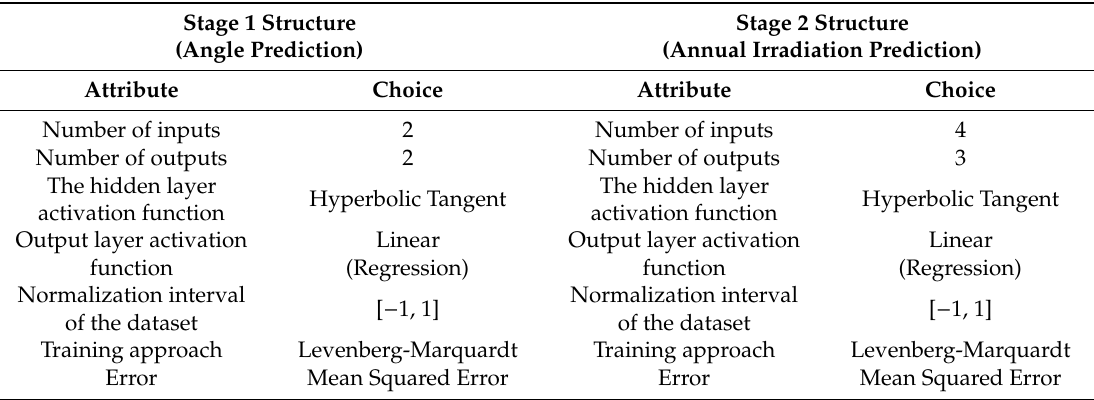
Table 2. The parameters of the proposed network models’ structures.